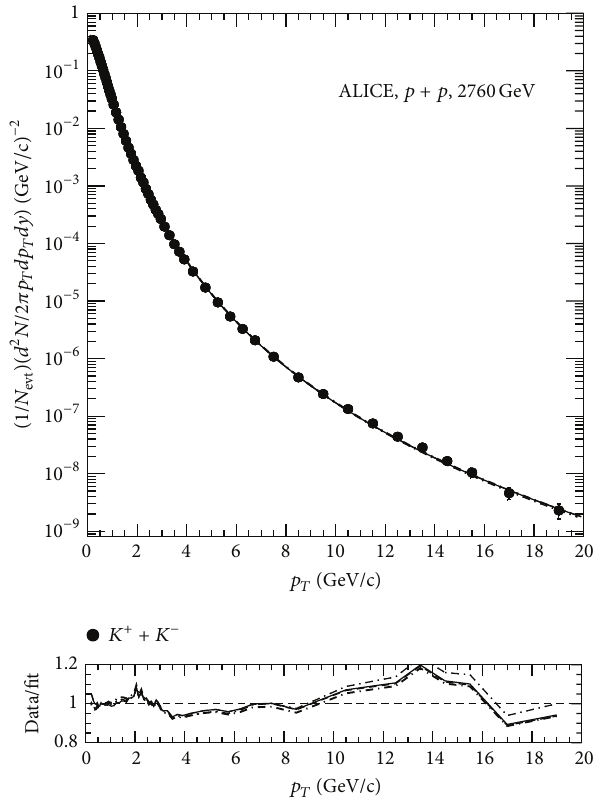
Figure 3: Same as in Figure 1 for 𝐾 + + 𝐾 − in 𝑝 + 𝑝 collisions at √𝑠 = 2760 GeV. Data are taken from ALICE